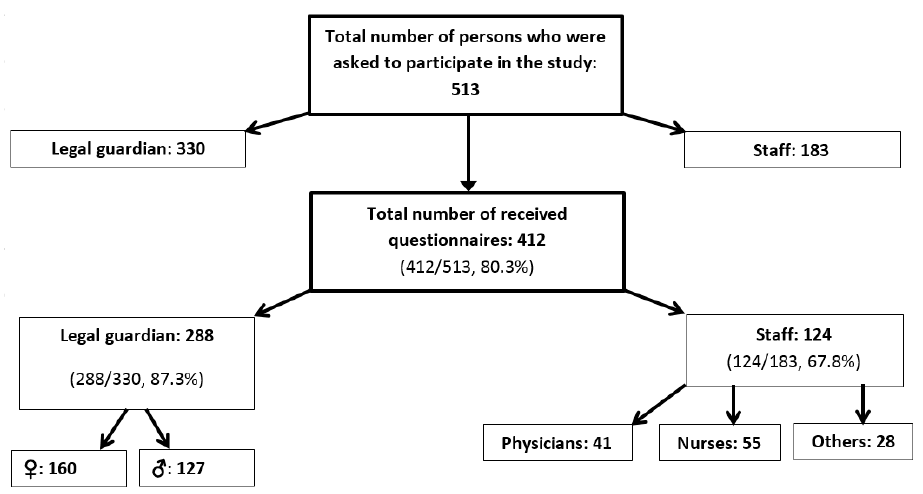
Figure 1. Flow chart of the recruitment process for the study.